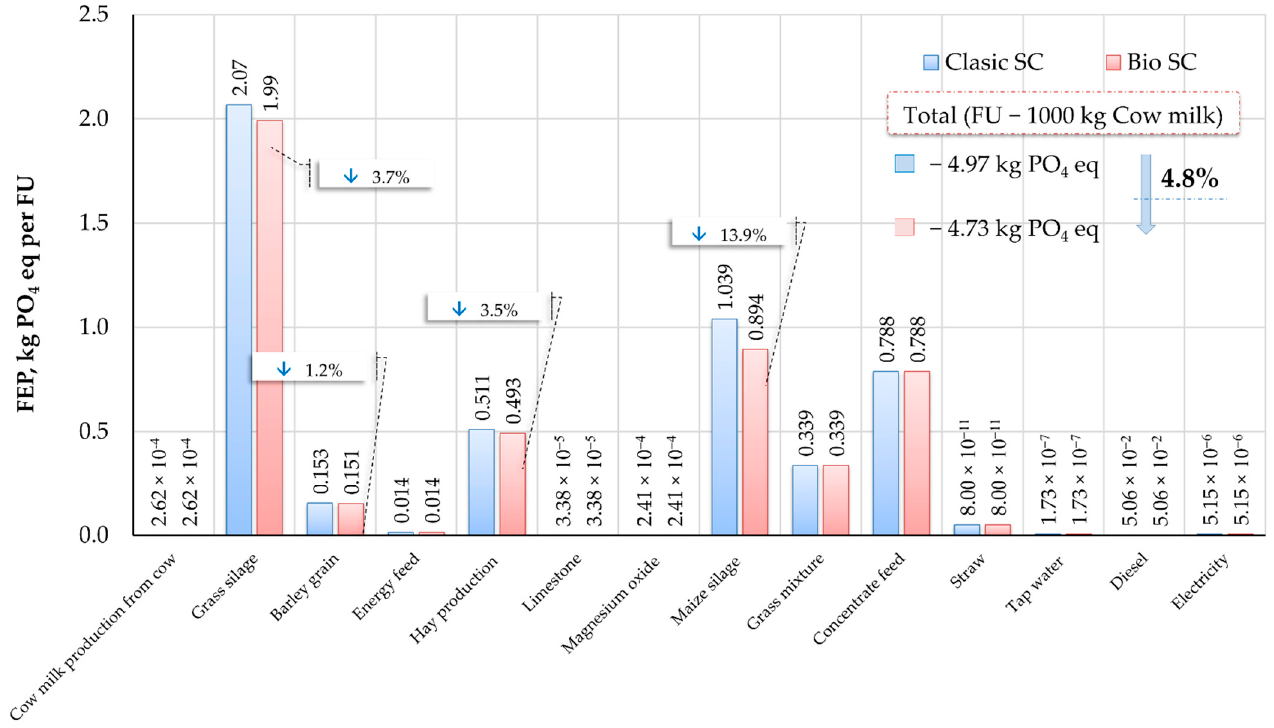
Figure 6. FEP of milk production stocks per FU.